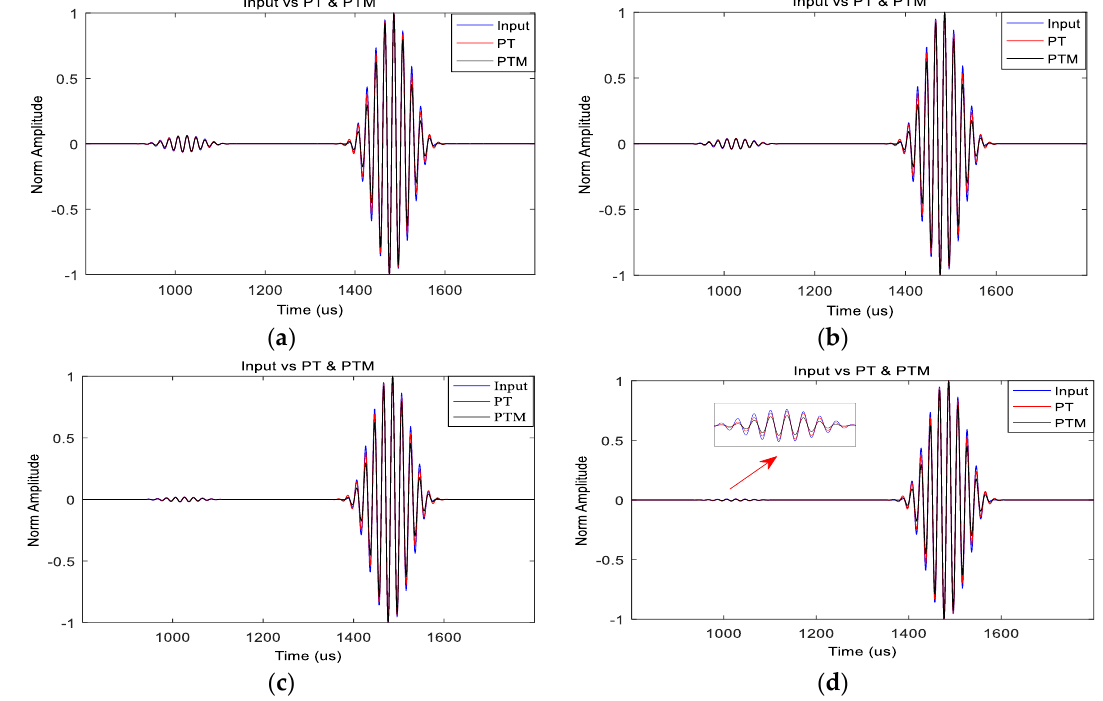
Figure 5. Results for the synthesised signal before and after applying SSP ((polarity thresholding & Polarity thresholding with minimisation)PT & PTM). The defect and the pipe end are located at X = 3 m and X = 4.5 m from the excitation signal. The defect sizes are ( a ) 6% cross-section area (CSA); ( b ) 4% CSA; ( c ) 2% CSA; and ( d ) 1% CSA.